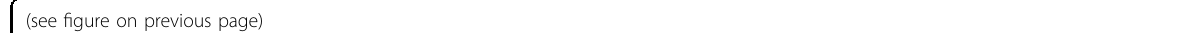
Fig. 3 MNT interacts with REL through its C-terminal region in the cytoplasm and the nucleus. a Co-immunoprecipitation assays with anti- MNT and anti-p65 antibodies (the IgG as a negative control) in URMT and URMax34 after Zn 2 + treatment. The inputs are shown in the left panel. b Co-immunoprecipitation assay with MNT antibodies (MNT 50 , an antibody against the 50 fi rst amino acids of MNT protein; MNT 582 , an antibody against the 532 – 582 amino acids of MNT protein), and with p65 and p105/p50 antibodies, and IgG as a negative control. Two immunoblots for REL are shown (low and high intensity). c Working hypothesis with two options: MNT bound to REL homodimers, MNT bound to REL and other yet unknown protein(s). d Schematic representation of the mouse MNT deletion constructs used for the co-IP assays, Δ bHLH and Δ Ct1 MNT-HA. The dotted red lines connect the domains of MNT and REL necessary for the interaction. e C6 cell lysates 48 h after transfection with REL- fl ag (mouse) and Δ bHLH or Δ Ct1 MNT-HA (mouse) were immunoprecipitated with anti-HA antibodies (IgG as negative control). The immunoblot of HA and REL is shown. The asterisk marks the heavy IgG band. f C6 cells were lysed following the nucleus/cytoplasm fractionation protocol, both in basal conditions or 30 min after treatment with TNF α (100 ng/mL) and immunoprecipitated with an anti-MNT antibody or the IgG (the latter as a negative control). The presence of REL, MNT, and MAX was determined in the immunoprecipitates by immunoblot. RhoGDI and SIN3B were analyzed as cytoplasm and nucleus markers, respectively. Coomassie blue was used as a protein loading control for the inputs. The asterisk marks the light IgG